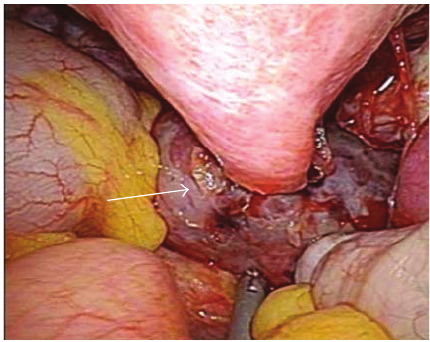
Figure 4: A single-port laparoscopic view showing the necrotized subserosal myoma with torsion at its pedicle in the cul-de-sac